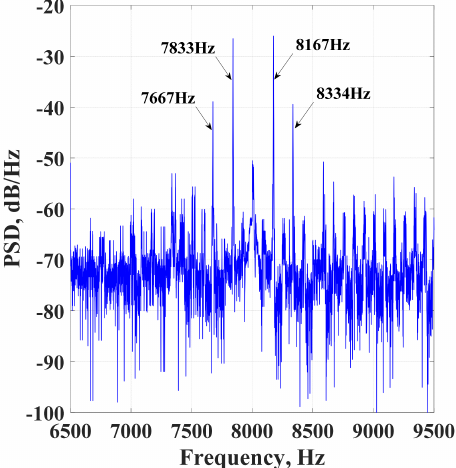
Figure 7. The sideband current harmonics with the conventional SVPWM.